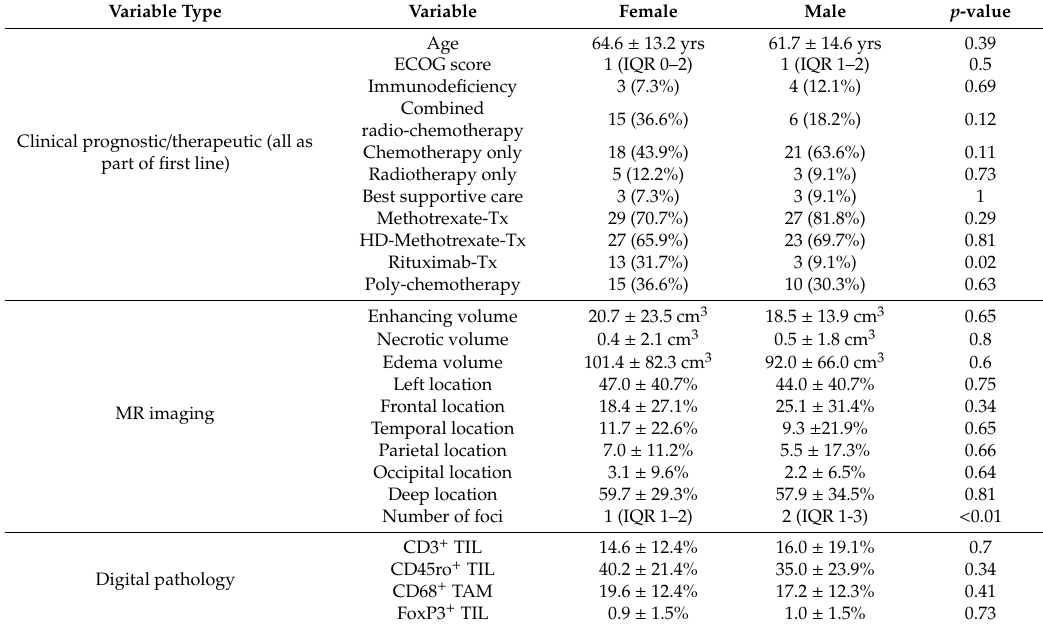
Table 1. Comparisons of the parameters between the female and male patients. Numerical data is given as (mean ± standard deviation); ordinal data is given as (median (interquartile range)); nominal data is given as (absolute frequency (relative frequency)). p -values were calculated with t -tests for numerical variables, Mann–Whitney U tests for ordinal variables, and Fisher’s exact test for nominal variables. TIL: tumor-infiltrating lymphocytes. TAM: tumor-associated macrophages. HD-Methotrexate: High-dose Methotrexate (dose ≥ 3 g / m 2